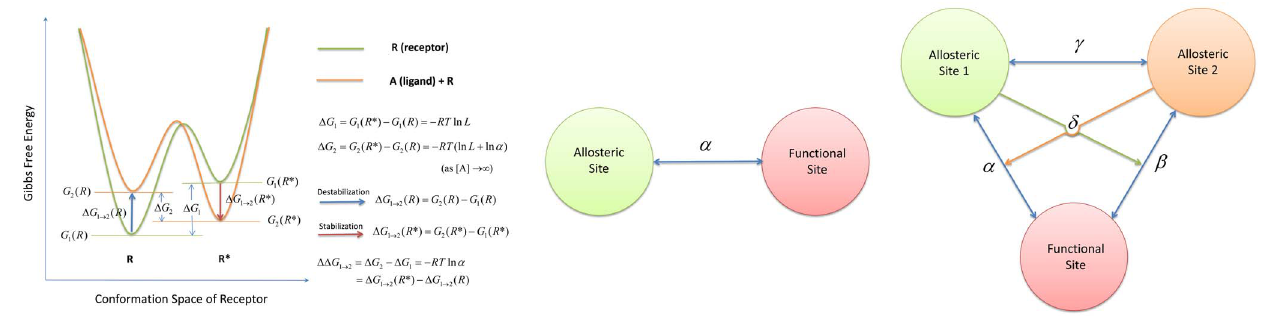
Figure 5. The thermodynamic and free energy landscape of the population shift views, the structural view of the allosteric two- state model, and an extension of the model to two allosteric sites and one functional site. (A) The free energy landscape presentation of ATSM. Before binding, the relative free energy between the inactive ( R ) and active ( R (cid:2) ) states is given by D G 1 ~ G 1 R (cid:2) ð Þ { G 1 R ð Þ , which is D G 1 ~{ RTlnL according to the ATSM as depicted by the light green curve. After binding, the relative free energy between R and R (cid:2) is given by D G 2 ~ G 2 R (cid:2) ð Þ { G 2 R ð Þ , which under a saturating ligand concentration becomes D G 2 ~{ RT lnL z ln a ð Þ , as drawn by the orange curve. The extent of population shift as measured by the free energy change due to binding, DD G 1 ? 2 , is equal to D G 2 { D G 1 ~{ RTln a . This result implies that the allosteric effect is solely determined by the allosteric efficacy, a , but not the absolute ligand affinity. DD G 1 ? 2 can also be expressed by the difference between the active conformation stabilization energy , D G 1 ? 2 R (cid:2)ð Þ ~ G 2 R (cid:2) ð Þ { G 1 R (cid:2) ð Þ (red arrow), and inactive conformation destabilization energy , D G 12 R ð Þ ~ G 2 R ð Þ { G 1 R ð Þ (blue arrow). (B) The structural view of allostery according to the ATSM. The allosteric communication between the allosteric and functional sites is indicated by the arrow with the coupling specified by the allosteric efficacy a . Unlike the thermodynamic view, the structural view emphasizes that the conformations of two sites breathe dynamically in a concerted motion through a set of mutually interacting residues. Without such a propagation channel between sites, a ~ 1 is always the case, no matter the changes at the allosteric site. Thus, while a preexisting channel (or allosteric networks of correlated residues) is a required condition, by itself the communication through the channel does not determine the allosteric efficacy. (C) The structural view of allostery according to the extended ATSM. In the drawing, the two allosteric communication channels between the two allosteric sites and the functional site are indicated by the blue double arrows with the coupling specified by the allosteric efficacy a , b from the extended ATSM. The communication between the two allosteric sites is linked with a coupling specified by the binding cooperativity, c , which is shown not to affect the allosteric efficacy directly. The activation cooperativity d is the sum of the allosteric effect of site 1 toward coupling b (pale green arrow) plus allosteric site 2 toward allosteric coupling a (orange arrow). As in the simplest ATSM, it is the ligand binding itself that puts forth the allosteric communications through existing propagation channels and determines the allosteric efficacy and the activation cooperativity either positively or